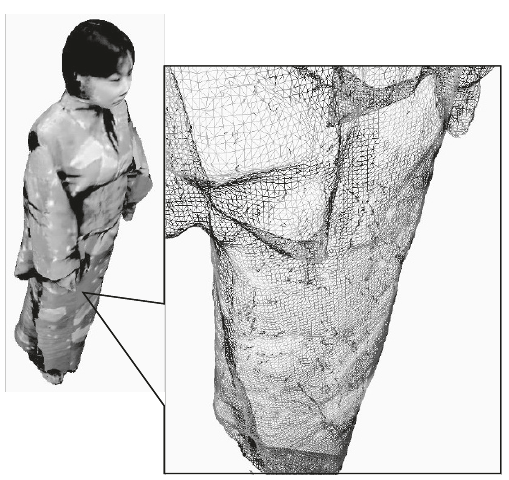
Figure 1: Example frame of our 3D video data. Each frame is de- scribed in a VRML format and consists of coordinates of vertices, their connection, and